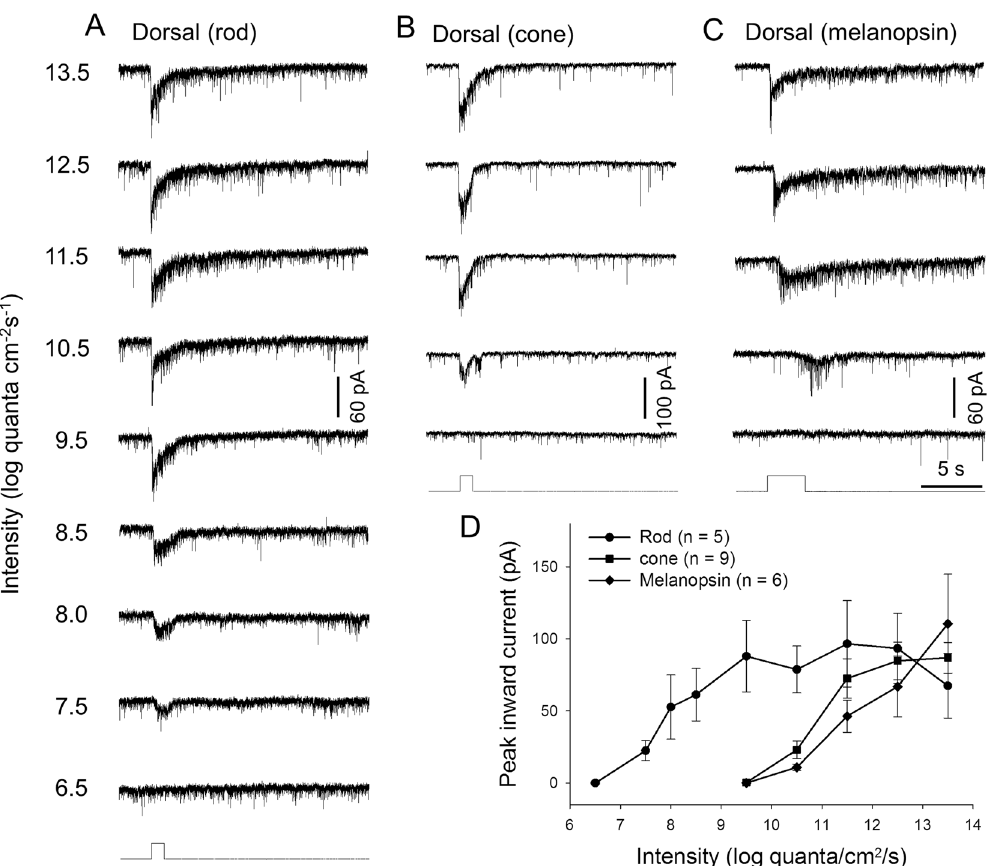
Figure 2. Relative contributions of rods, M-cones and melanopsin to dark-adapted dorsal DAC light responses. Light-evoked EPSCs of a dark-adapted dorsal DAC in a rod-function-only retina showing responses to a series of light stimuli ranging in intensity from 7.5 to 13.5 log quanta/cm 2 /s ( A ). M-cone-mediated responses of a DAC in a cone-function-only retina ( B ) demonstrate that its threshold intensity is three log units greater than that of rod-mediated responses. Melanopsin-based responses of a DAC ( C ) show the same threshold intensity as M-cone-mediated responses. Stimulation bar shows timing of light pulse (1-s duration, white light pulse). ( D ) Intensity-response profiles showing the average peak amplitudes of DAC light-evoked EPSCs as a function of the light intensity. Closed circles: rod-mediated responses; closed squares, M-cone-mediated responses; closed diamonds, melanopsin-based responses. Each data point shows the average and SE of multiple